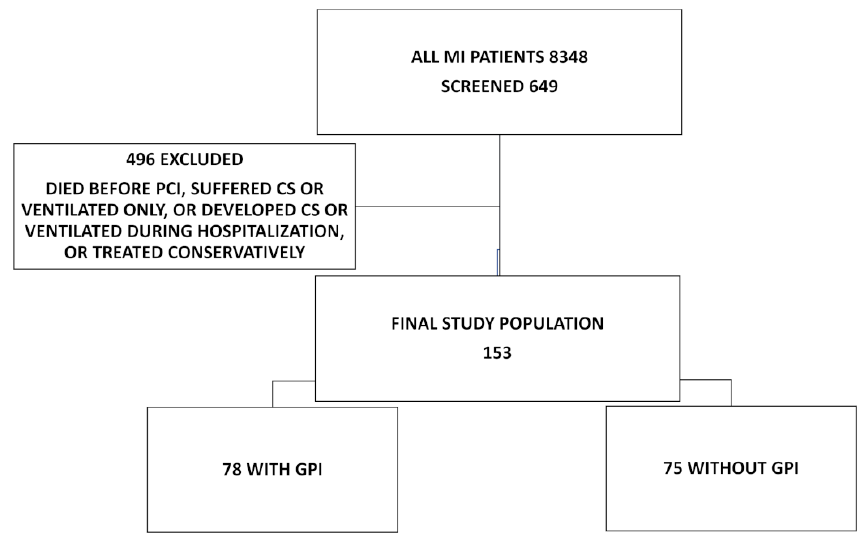
Figure 1. Study population. GPI = GP IIb/IIIa receptor inhibitor; MI = myocardial